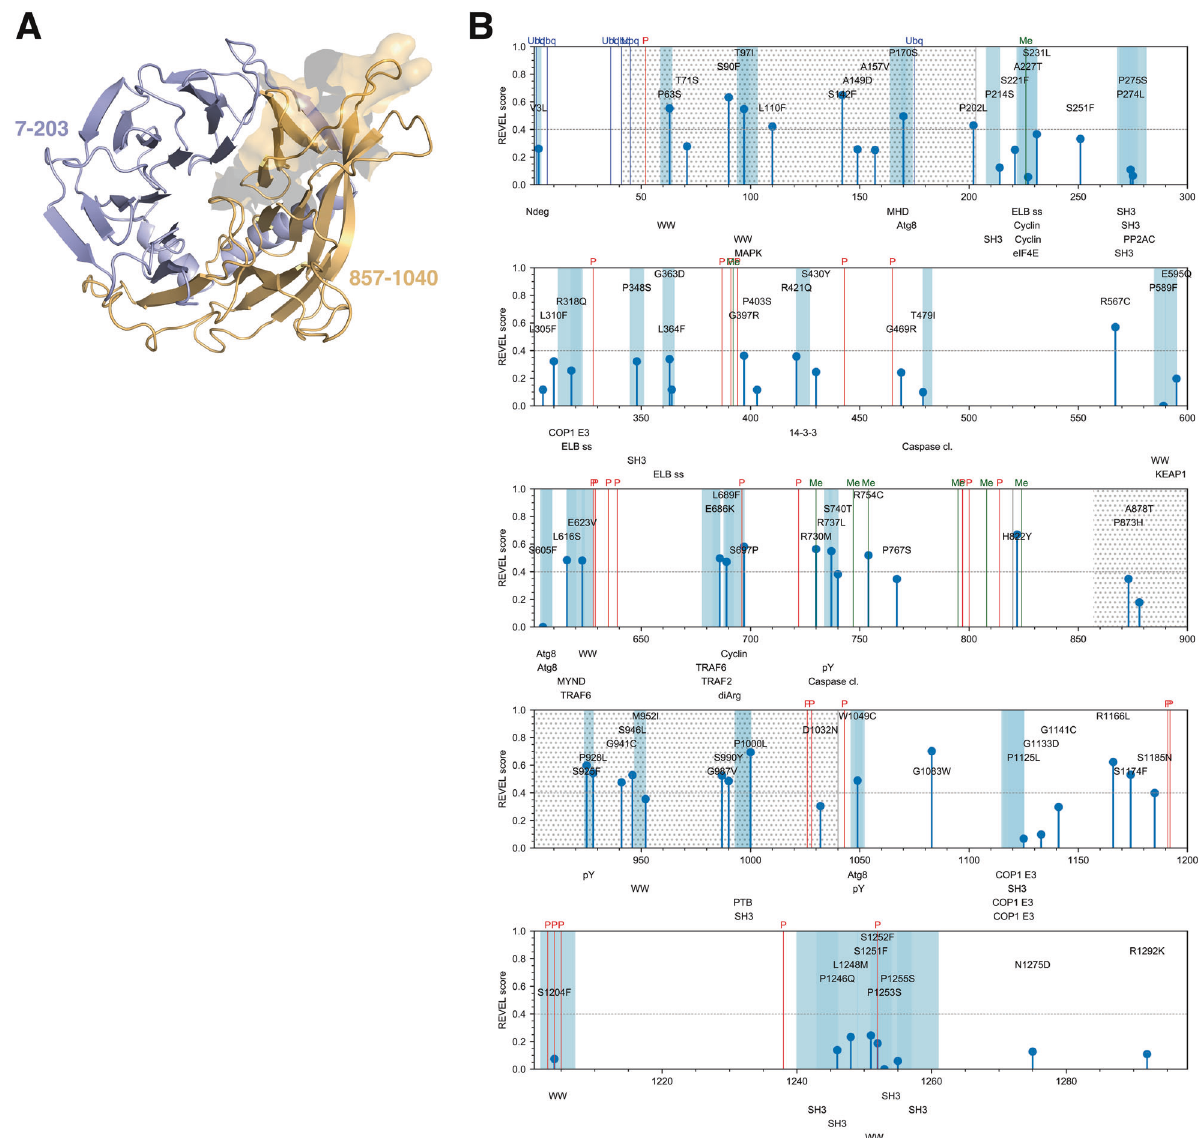
Fig. 2 Predicted structured regions of AMBRA1 and identi fi ed cancer mutations. A predicted structured regions of AMBRA1 including the β -propeller domain. The N-terminal and C-terminal regions of the model are shown in blue (7 – 203) and orange (857 – 1040), respectively. In the N-terminal region, we included in the model the helical structures (residues 7 – 41) that are upstream of the propeller domain since they were predicted with high con fi dence by AlphaFold2. The part of this structured region against which the AMBRA1 antibody for the C-terminal region we have used has been raised is also highlighted by showing its molecular surface (top right). B Melanoma-related mutations and corresponding annotations as collected by Cancermuts. Plots follow the main Uniprot sequence numbering; each mutation is annotated as a stem the height of which is proportional to the identi fi ed REVEL score (with 0 for those that could not be annotated). Blue shades and corresponding bottom labels refer to linear motifs as annotated by ELM. Post-translational modi fi cations are shown as colored vertical lines. A gray dotted pattern was used to represent the predicted structured β -propeller domain of AMBRA1. Predicted SLIMs that do not overlap with mutations have been hidden from this plot for ease of